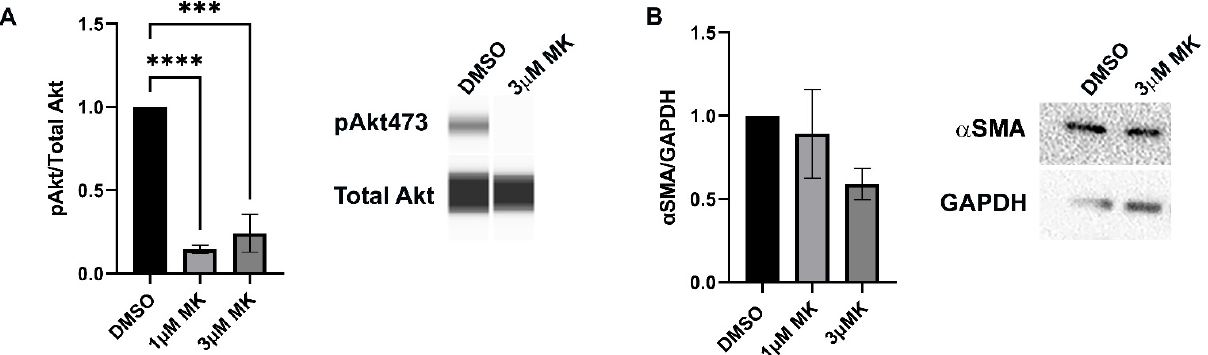
Figure 3. Role of Akt in mediating myofibroblast differentiation. ( A , B ) Ex vivo post-cataract surgery wounded explants were treated with vehicle (DMSO) or the Akt specific inhibitor MK-2206 (MK) on day 1 through day 3 and subjected to immunoblot analysis. ( A ) The activation state of the PI3K effector Akt was determined by immunoblotting for phosphoSer473-Akt (pAkt) and total Akt. Quantification of the relative intensity of pAkt/total Akt, normalized to DMSO is displayed in the bar graph. ( B ) Immunoblots of D3 vehicle and MK2206 treated ex vivo post-cataract surgery explant lysates shown for α SMA and loading control GAPDH. Quantification of the relative intensity of α SMA and GAPDH normalized to DMSO is displayed in bar graphs ( n = 3). Results show that MK treatment effectively suppressed activation of Akt and that there was a dose dependent decrease in α SMA expression; however, the changes in α SMA expression were not found to be statistically sig- nificant. Error bars represent S.E.M., *** p ≤ 0.001, **** p ≤ 0.0001.